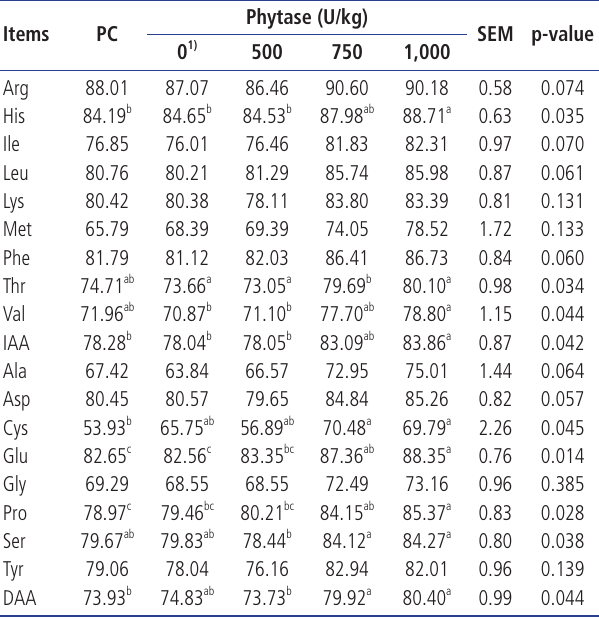
Table 5. Effect of phytase on apparent ileal digestibility of amino acid in 28-d old Youxian Sheldrake Items